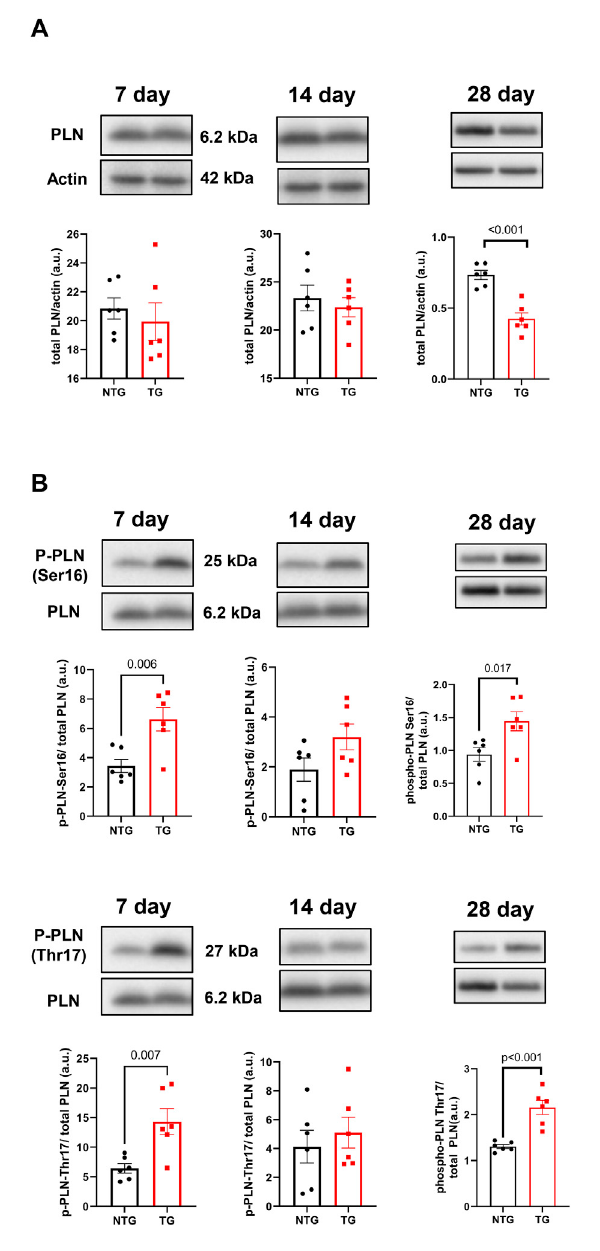
FIGURE 10 The effects of R92Q-cTnT on calcium signaling — phospholamban (PLN) abundance and phosphorylation. Western blot analysis of PLN abundance (A) and phosphorylation of PLN at Ser16 and Thr17 (B) in NTG and TG hearts. NTG, non- transgenic; TG, transgenic. Data presented as mean ± SEM